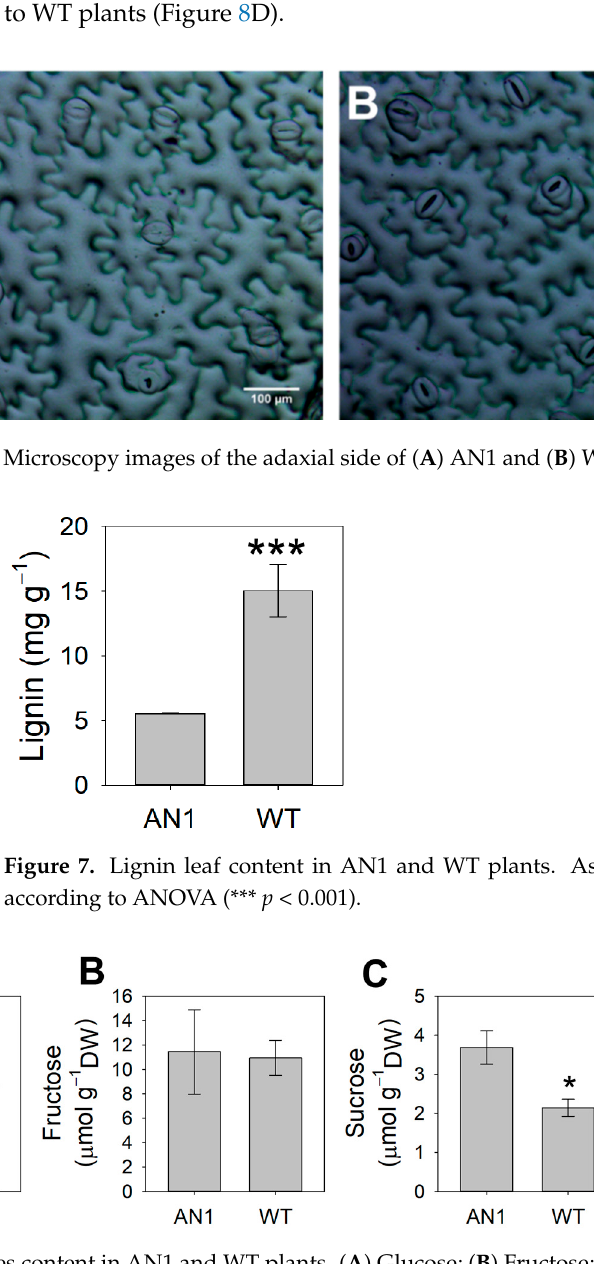
Figure 8. Leaf carbohydrates content in AN1 and WT plants. ( A ) Glucose; ( B ) Fructose; ( C ) Sucrose; ( D ) Starch. Asterisks indicate significant differences according to ANOVA (* p < 0.05; ** p < 0.01).